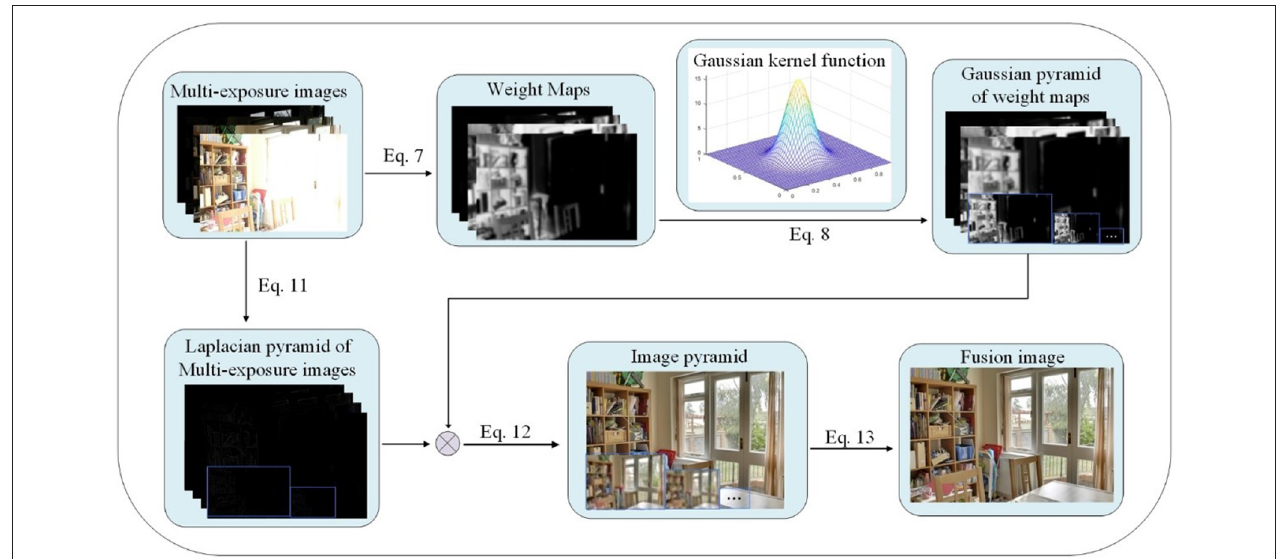
FIGURE 1 | The workflow of the proposed image fusion based on improved weight function.